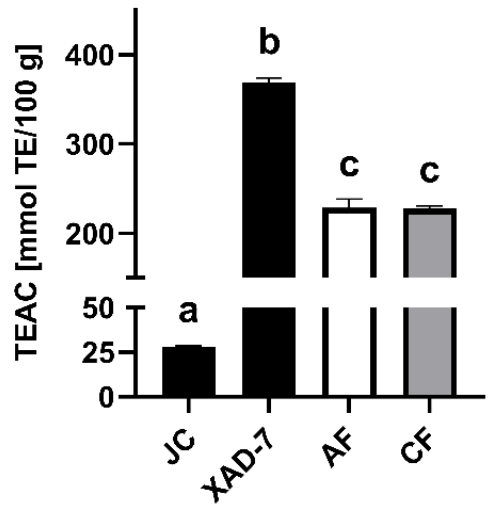
Figure 2. Trolox equivalent antioxidant capacity (TEAC) calculated as Trolox equivalent (TE) per 100 g or 100 mL of lingonberry juice concentrate (JC), XAD-7 extract, its anthocyanin (AF) and copigment fraction (CF). Results are presented as mean ± SD of three independent experiments. Different letters represent statistically significant differences ( p < 0.0001) within the samples. The antioxidant potential was additionally examined against galvinoxyl and DPPH radicals by ESR spectroscopy, which revealed comparable results (Figure 3). For galvinoxyl radicals, XAD-7 extract ( IC 50 = 14.84 µ g/mL; Figure 3A) showed the highest scaveng- ing activity, while higher concentrations of AF ( IC 50 = 31.44 µ g/mL; Figure 3B) and